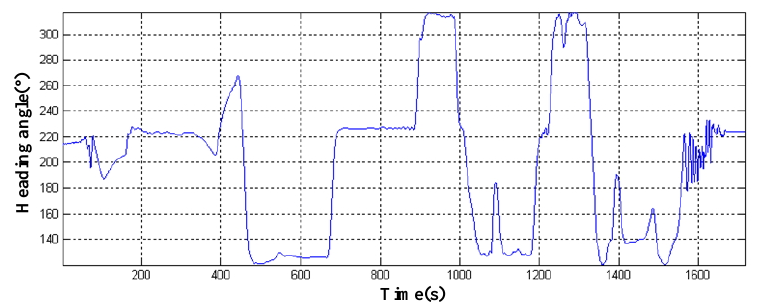
Figure 18. Experiment result with adaptive predictive PID control method.